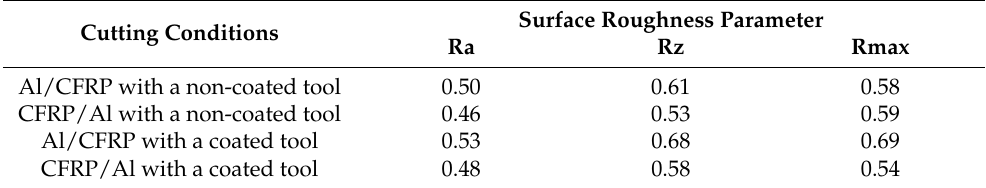
Table 6. Values of the coefficient I R for the considered surface roughness parameters depending on the machining configuration and the type of